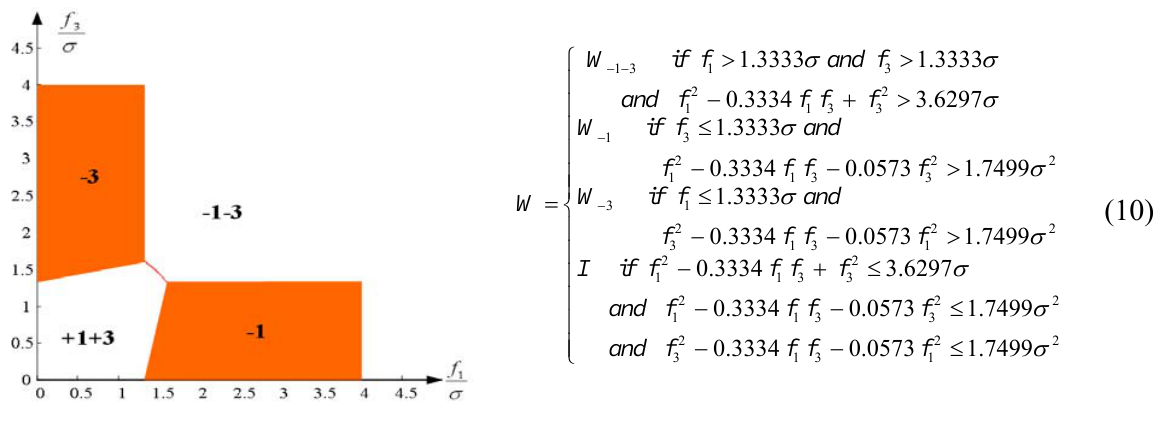
Figure 14. Accommodation rule for 1 st and 4 th faulty sensors for configuration